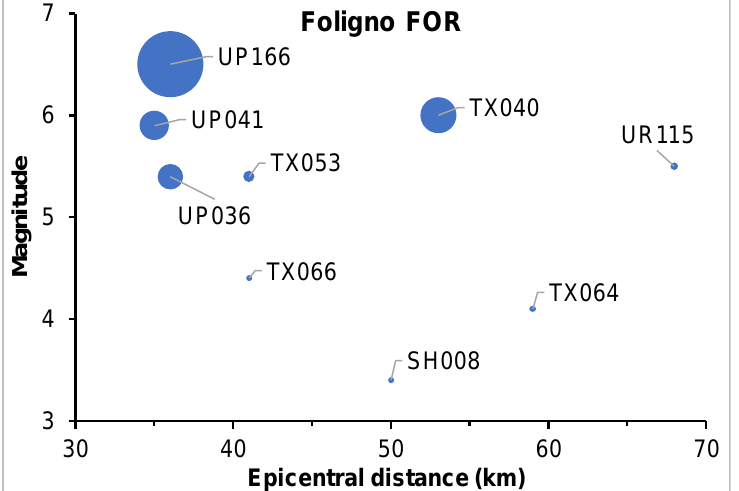
Figure 13. Magnitude versus epicenter distance for the recorded events. The areas of the circles are proportional to I A , except for events with M < 5.